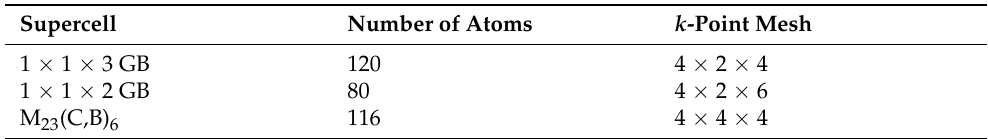
Table 1. k -point mesh sampling of different supercells.